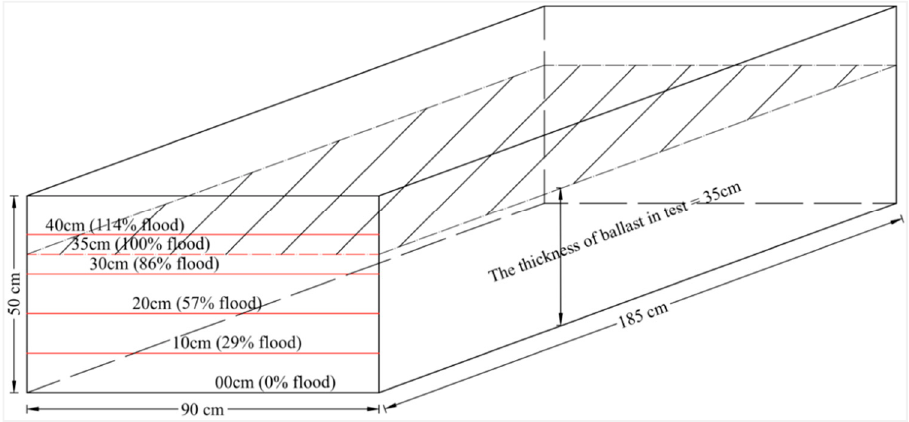
Figure 8. The flooding ballast at different levels.